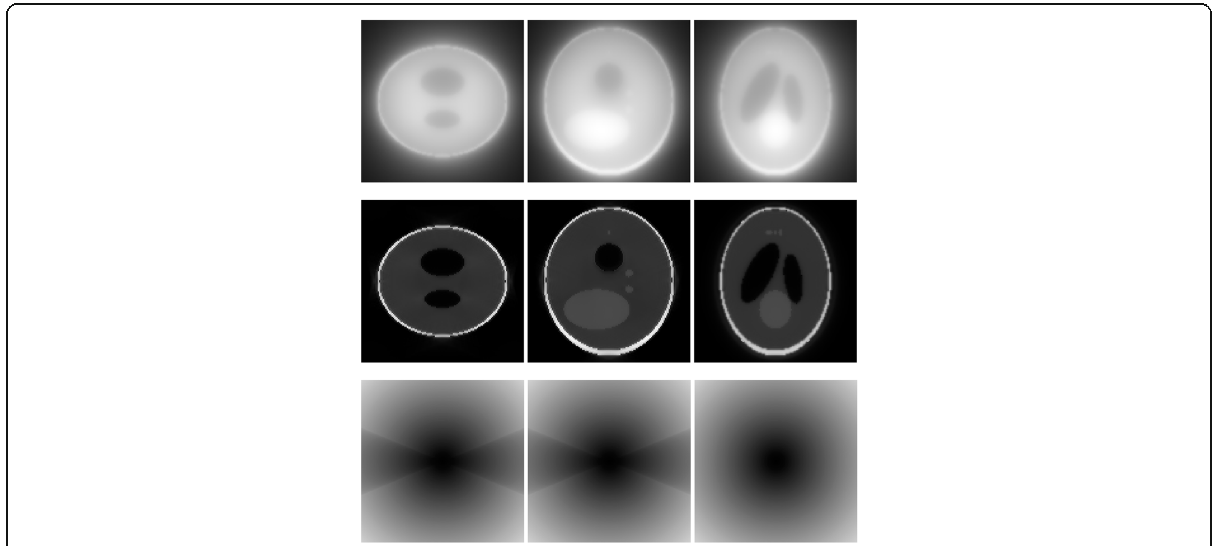
Fig. 11 Image reconstruction using proposed algorithm for the case of ψ = 3 π /8 and σ = 100. Row 1: TOF backprojection. Row 2: Final reconstruction. Row 3: Tomographic filter H . Three central orthogonal cuts are shown for each